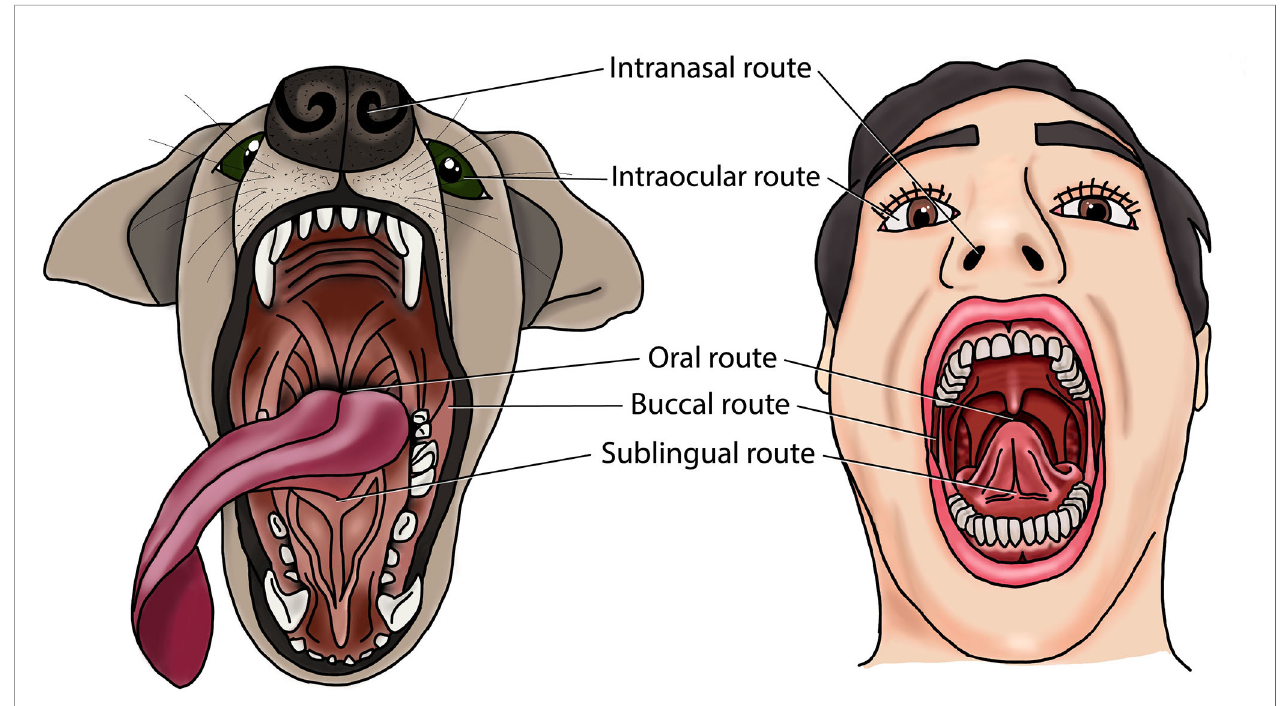
FIGURE 1 | Mucosal routes for periodontal disease vaccination in dogs and